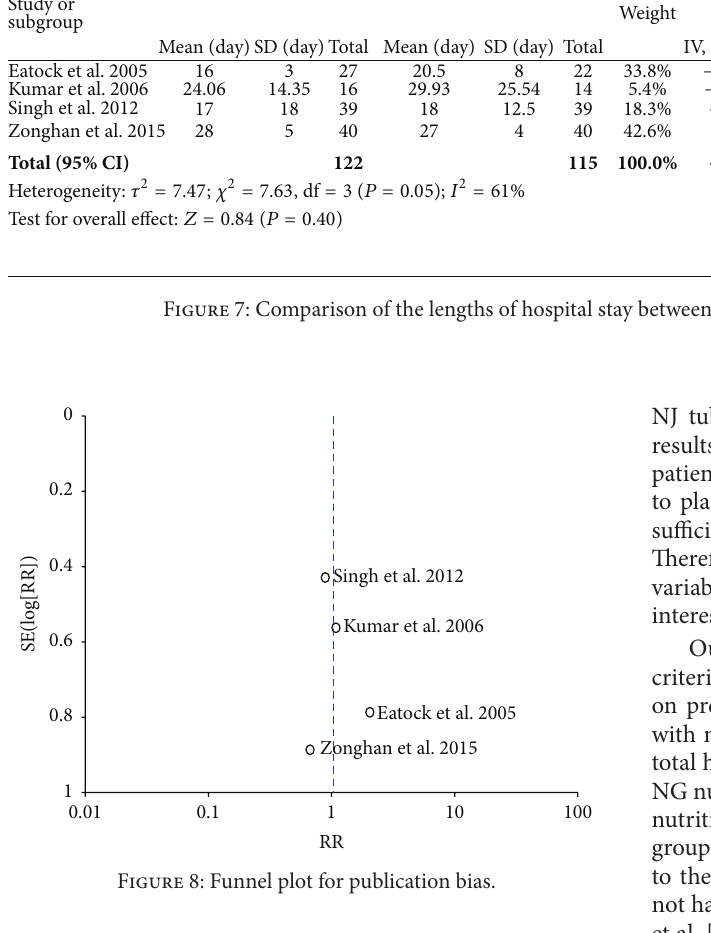
placement of the NG tube, and NG nutrition is preferred for these